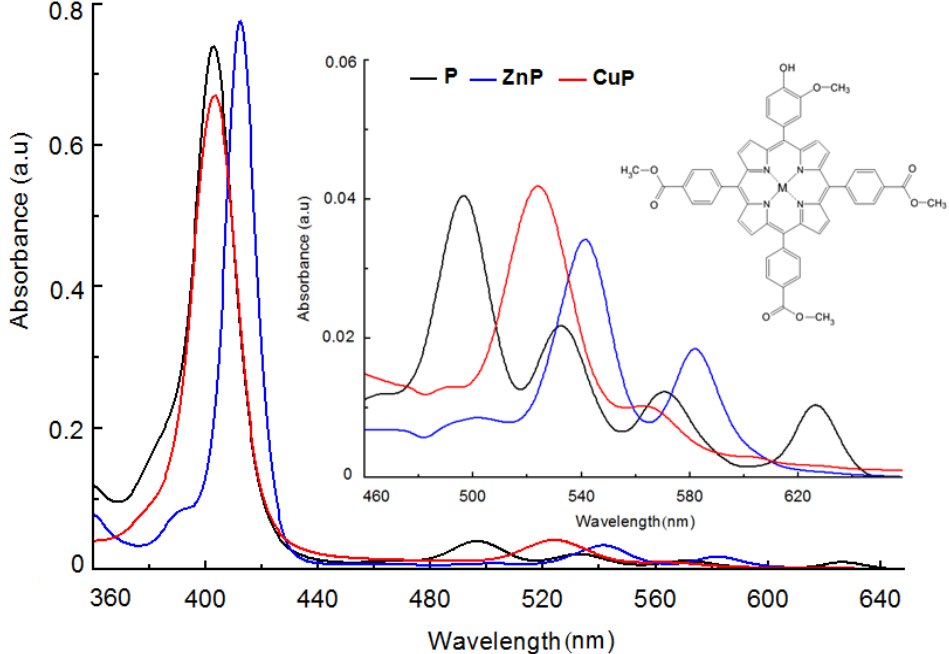
Figure 2. Absorption spectra for: 5-(4-hydroxy-3-methoxyphenyl)-10,15,20-tris(4-carboxymethylphenyl) porphyrin (P), 5-(4-hydroxy-3-methoxyphenyl)-10,15,20-tris(4-carboxymethylphenyl)porphyrinatozinc(II) (ZnP) and 5-(4-hydroxy-3-methoxyphenyl)-10,15,20-tris(4-carboxymethylphenyl)porphyrinatocopper(II) (CuP); (dimethylsulfoxide used as solvent) [31].